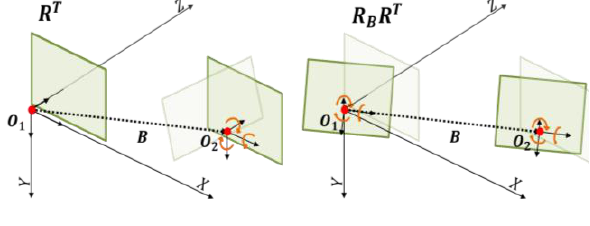
Figure 2. Epipolar resampling rotations